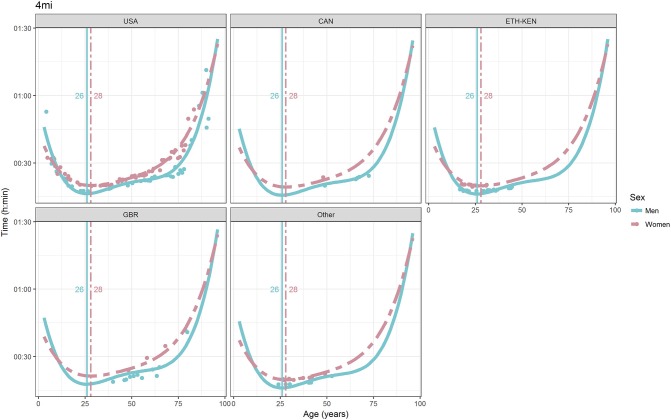
World record in 4 miles by sex, age (in years), and country. Points were observations. Curves represented quartic degree polynomial regression. Vertical lines with numeric labels were the ages at peak performance.